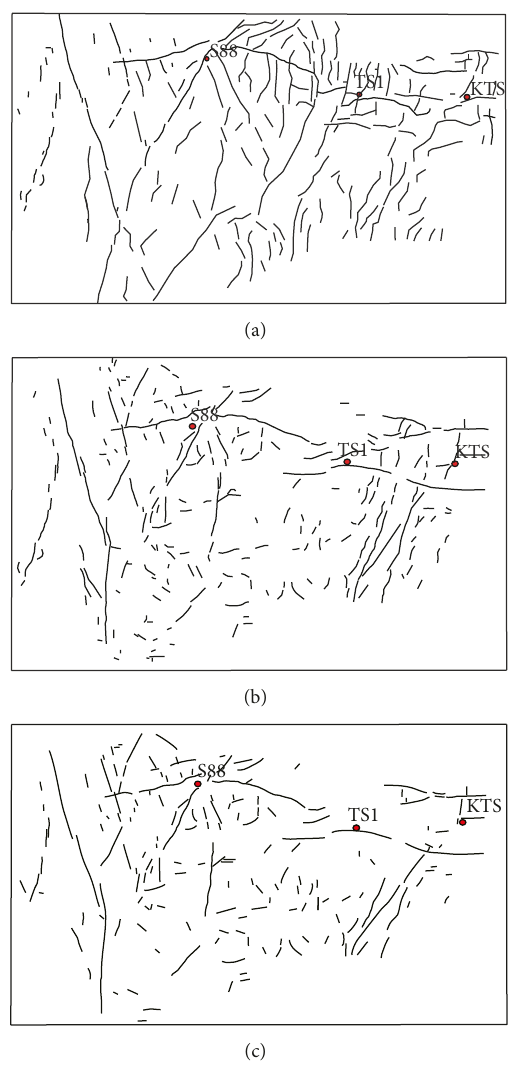
Figure 5: Spatial patterns of fault/fracture systems on some impor- tant stratal levels traced by seismic reflection surfaces in northern Tarim. (a) T9 0 (lower surface of Cambrian formation), (b) T8 0 (upper surface of Cambrian formation), and (c) T7 8 (upper surface of Lower Ordovician Penglaiba Formation) as indicated in Figure 3. Note the location of borehole